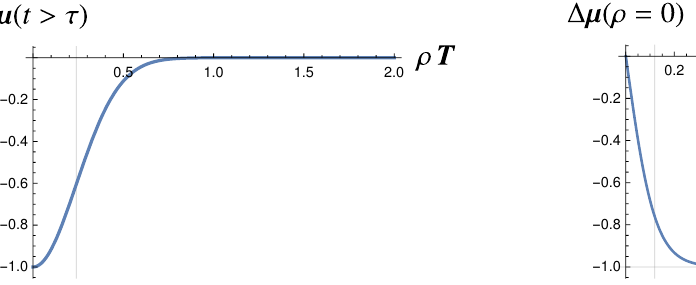
Figure 1 . The pro(cid:12)le of the perturbation in the chemical potential (3.1). Left | radial pro(cid:12)le given the characteristic size (cid:26) 0 = 1 z h = 0 : 25 T (cid:0) 1 (shown by a gridline). Right | temporal pro(cid:12)le of the fast quench (cid:28) 0 = 0 : 5 z h = 0 : 12 T (cid:0) 1 (shown by a